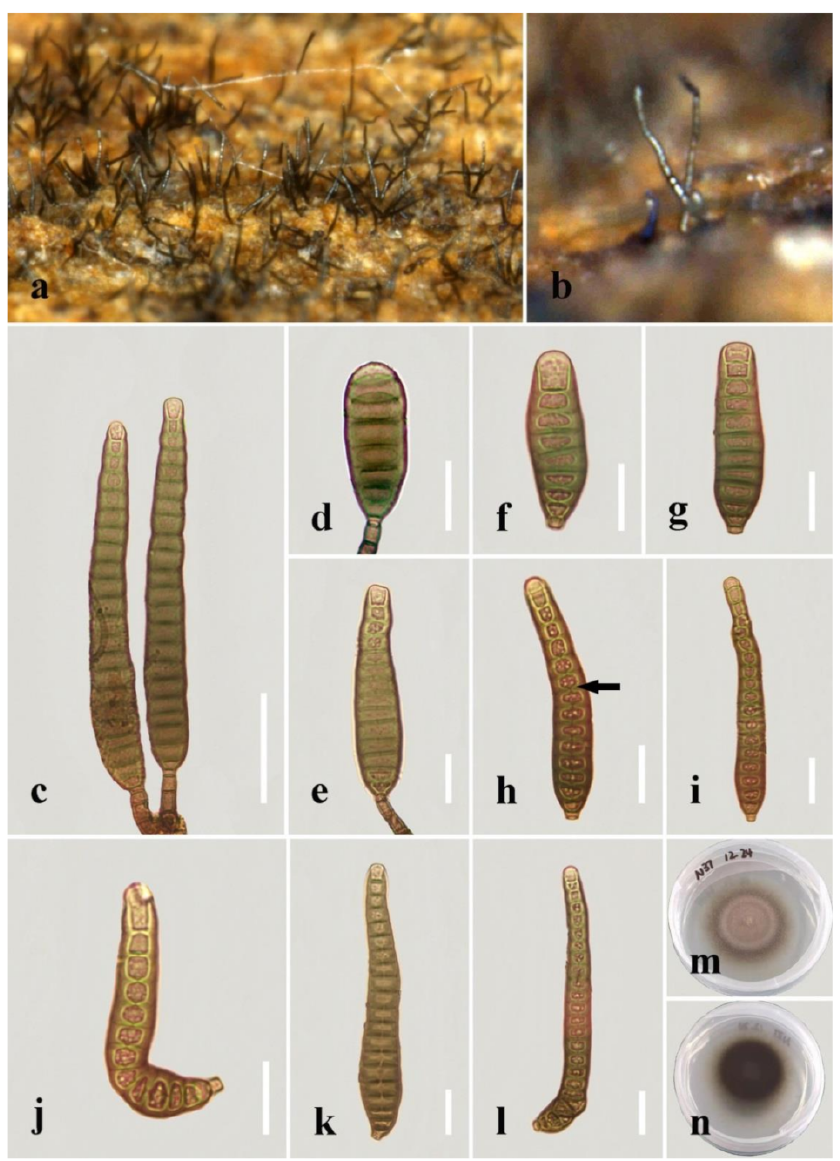
Figure 13. Distoseptispora pachyconidia (HKAS 122179, holotype). ( a , b ) Colonies on natural substrate. ( c ) Conidiophores with conidia. ( d , e ) Conidiogenous cells with conidia. ( f – l ) Conidia. The arrow in h points to a gap in the middle of the septum, which indicates the distosepta. ( m ) Colony on PDA (from front). ( n ) Colony on PDA (from reverse). Scale bars: ( c ) 40 µ m; ( d – l ) 20 µ m. Distoseptispora rayongensis J. Yang & K.D. Hyde, Mycosphere 11(1): 579 (2020) (Figure